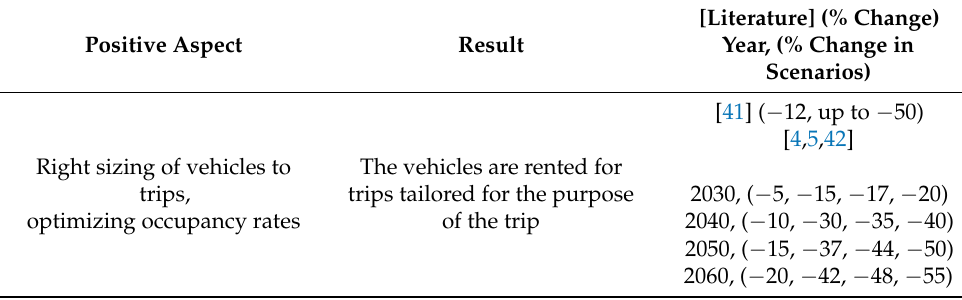
Table 6. Impacts of vehicle sharing on road transportation energy-use.